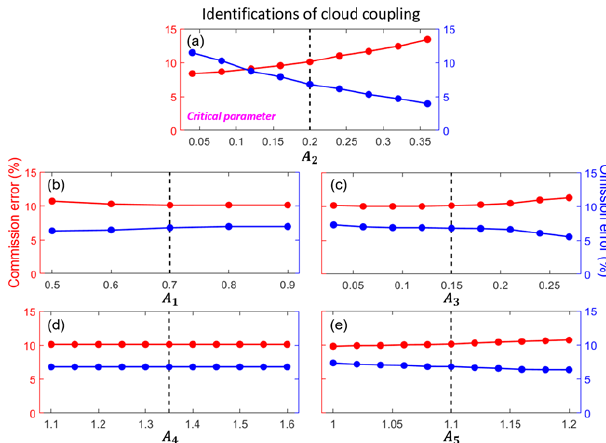
Figure 6. Commission errors (red line) and omission errors (blue line) of coupled cloud identifications for selecting different values of empirical parameters ( A 1 , A 2 , A 3 , A 4 , A 5 ) in the DTDS algo- rithm. Dashed black lines indicate the default values. For each test, one parameter is variable, while other parameters are set as default values. For identifications of cloud coupling, A 2 is the critical pa-